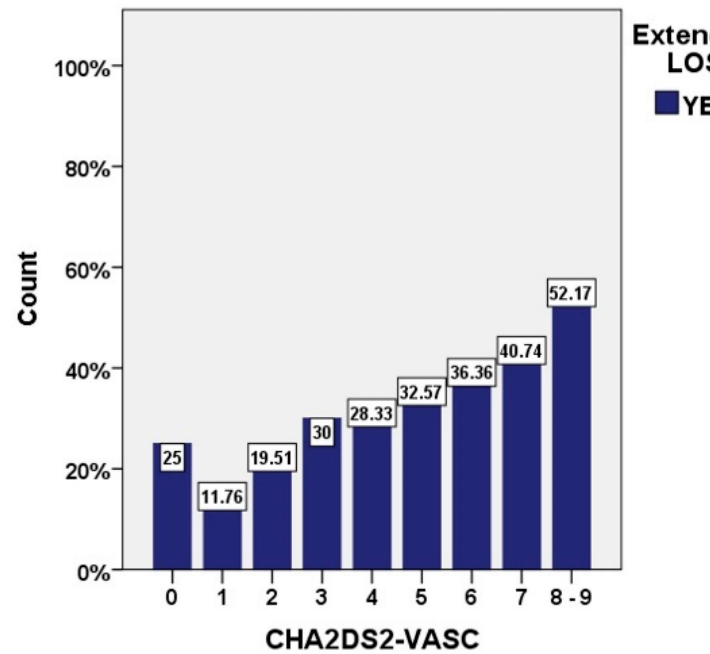
Figure 2. Incidence of prolonged LOS stratified by the CHA 2 DS 2 -VASc score.